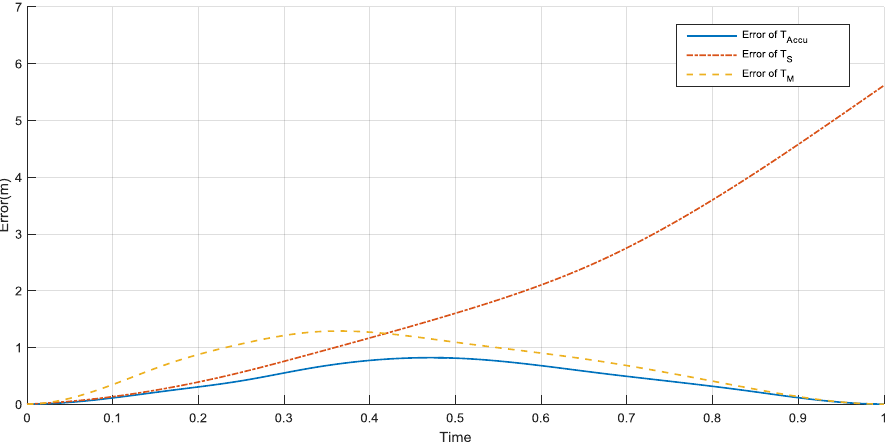
Figure 8. Trajectory error comparison. The error of T S increases throughout the maneuver; while the errors of T Accu and T M increase firstly and then decrease. T Accu is more in line with the real